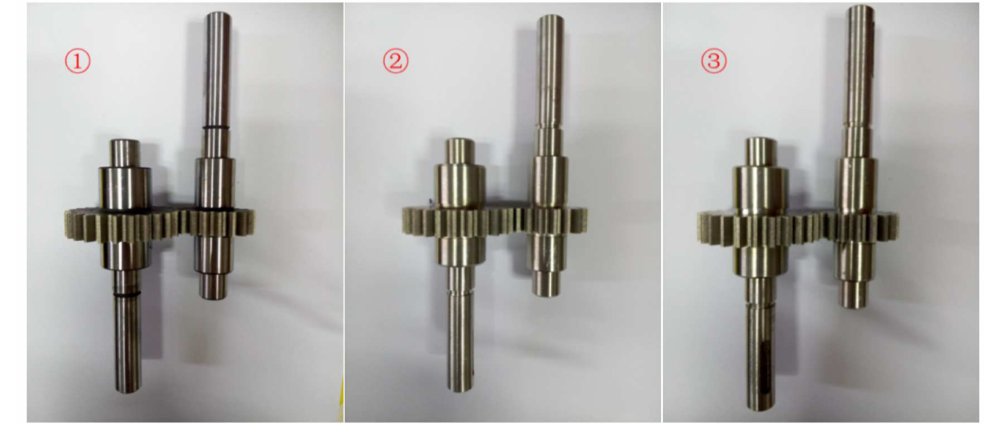
Figure 18. Three pairs of gears made of different